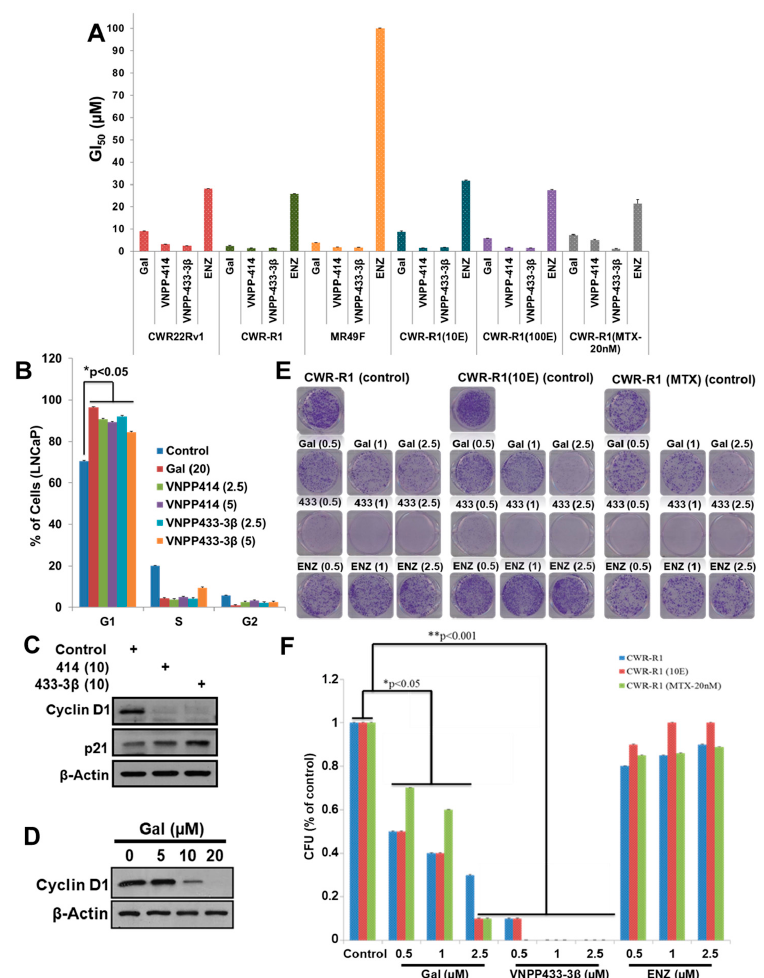
Figure 2. Gal and next generation galeterone analogs (NGGA) inhibit proliferation, colony formation and inhibit cell cycle progression of a variety of prostate cancer cell lines. ( A ) Comparative GI 50 values of Gal, NGGAs, and enzalutamide (ENZ) in drug-naïve-/-resistant prostate cancer cells. ( B ) Gal and NGGAs induce G1 cell cycle arrest in LNCaP cells. ( C ) VNPP414 and VNPP433-3 β deplete the cell cycle regulator, cyclin D1, and upregulate p21; “+” indicates specific treatments. ( D ) Gal cause dose-dependent depletion of cyclin D1. ( E ) Unlike ENZ, Gal and VNPP433-3 β inhibit colony formation of drug-naïve/-resistant cells in vitro. 1000 cells/well (CWR-R1, CWR-R1 (10E), CWR-R1-MTX20nM), seeded in 6-well plates were treated with indicated concentrations of compounds for a period of 14 days. Media containing compounds were replaced every 3 days. Colonies were stained with 0.05% crystal violet. ( F ) Quantification of colony formation units (CFU) in drug-naive/resistant cells. Colony assays were repeated three times and colonies counted in four quadrants of the wells. Results are represented as averages with S.E.M. (* p < 0.05, ** p < 0.001). Note: the numbers in parentheses in Figure 2B,C,E are concentrations of the agents in µM.